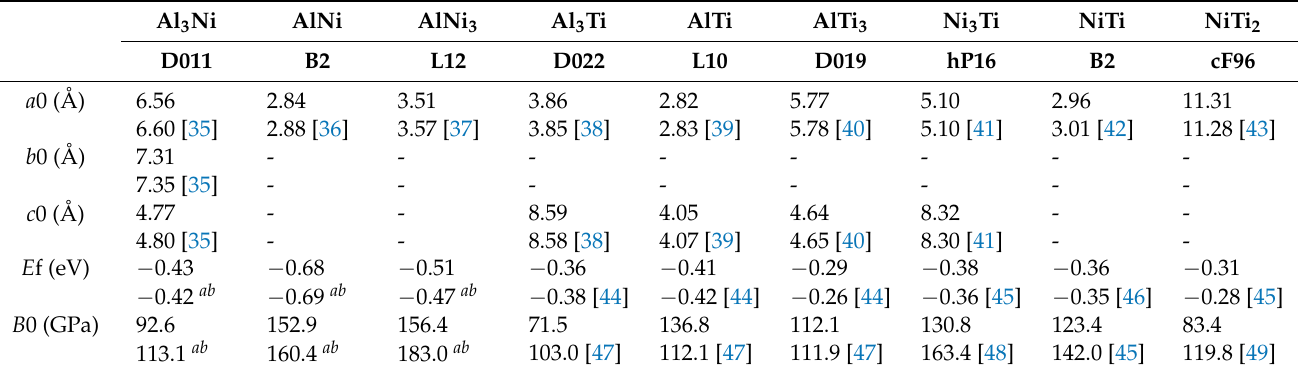
Table 3. Properties of Al-Ni, Al-Ti and Ni-Ti compounds used for fitting and the reproduced results: lattice constants ( a 0, b 0 and c 0), formation energy ( E f) and bulk modulus ( B 0).